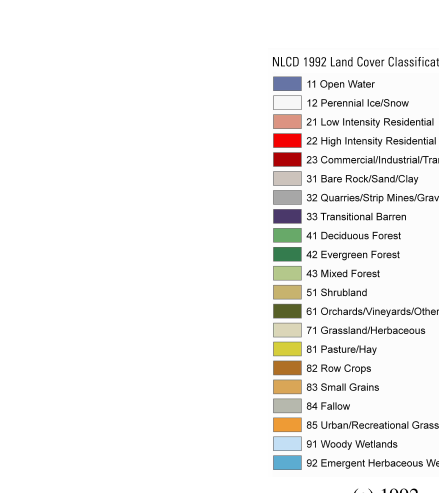
Figure 5: NLCD for the Phoenix MA.